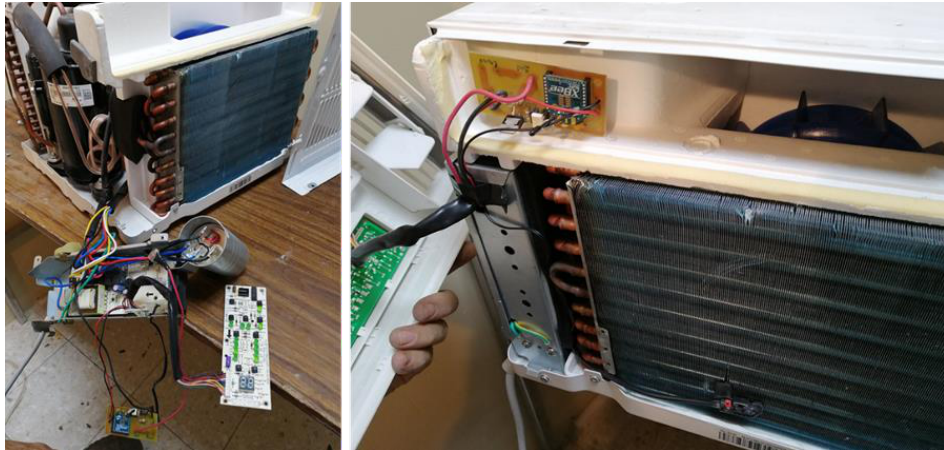
Figure 9. Raspberry Pi, sensor node, and electrical parameter meter.